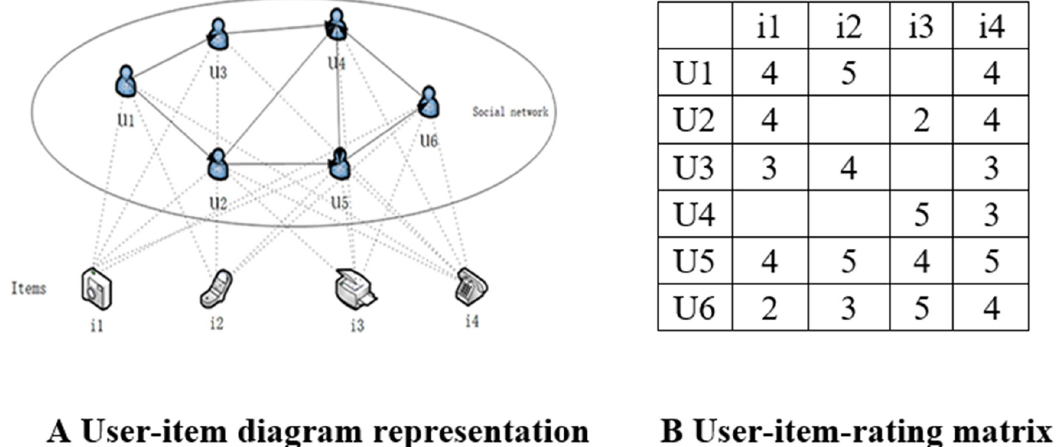
Fig 2. The expression of trust social network recommendations. A. User-item diagram representation. B. User-item-rating